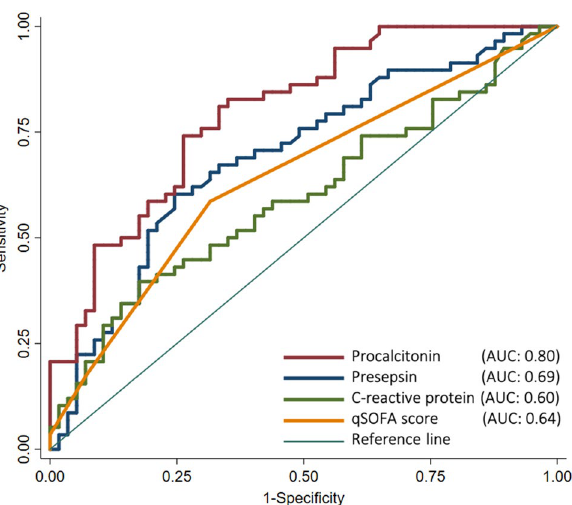
Figure 2. Receiver operating characteristic (ROC) curves of procalcitonin, presepsin, C-reactive protein, and qSOFA score for differentiating between patients with and without bacteremia. The ROC curve analysis showed the performance for predicting bacteremia: AUC of 0.80 (95% CI: 0.72–0.88) for procalcitonin, AUC of 0.69 (95% CI: 0.60–0.79) for presepsin, AUC of 0.60 (95% CI: 0.49–0.70) for C-reactive protein, and AUC of 0.64 (95% CI: 0.55–0.73) for qSOFA score. AUC, area under the curve; CI, confidence